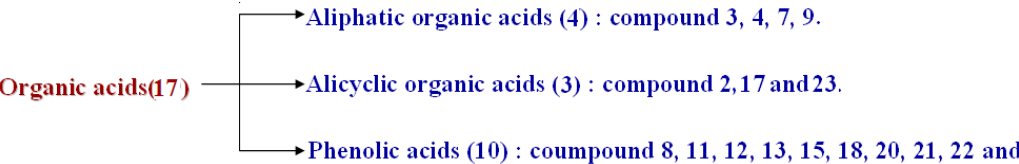
Figure 6. Organic acids identified in WZYZW by UPLC-ESI-LTQ-Orbitrap-MS.